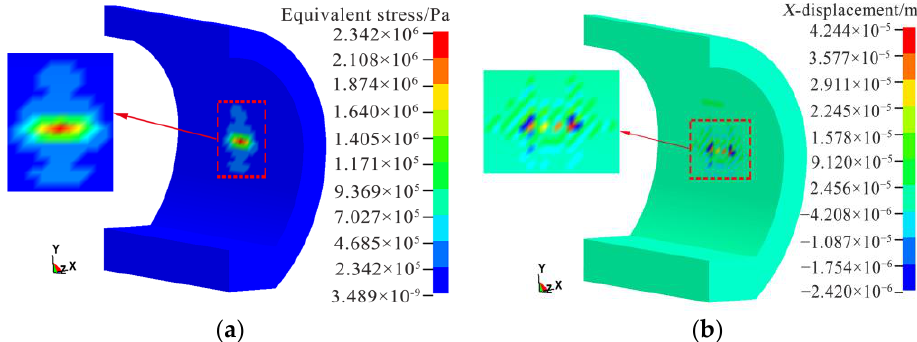
Figure 16. Horseshoe tunnel section. ( a ) Equivalent stress peak value. ( b ) Peak displacement in X -direction.